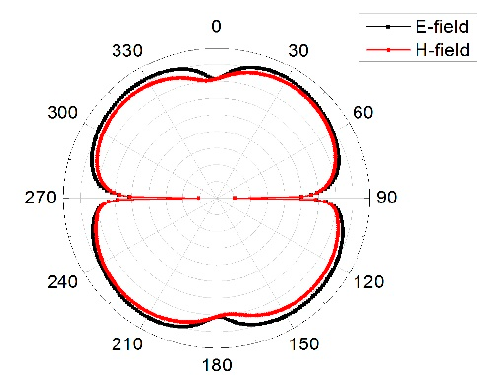
Figure 15. Modal surface current and modal 3D radiation pattern of 3 modes at 5.8 GHz; ( a , b ) mode 1, ( c , d ) mode 2, ( e , f ) mode 3.